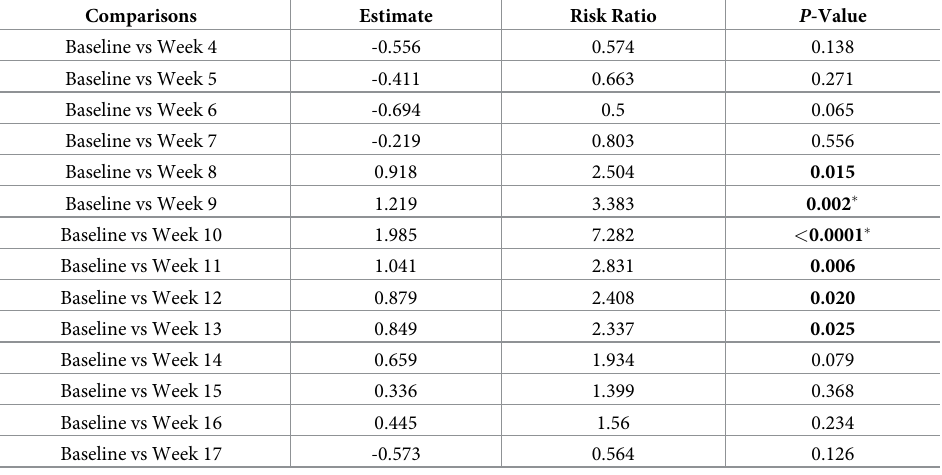
Scale estimate was 0.3163; Used negative binomial with a log link. Significant values are in bold � Statistically significant values after multiple testing adjustment with Bonferroni.